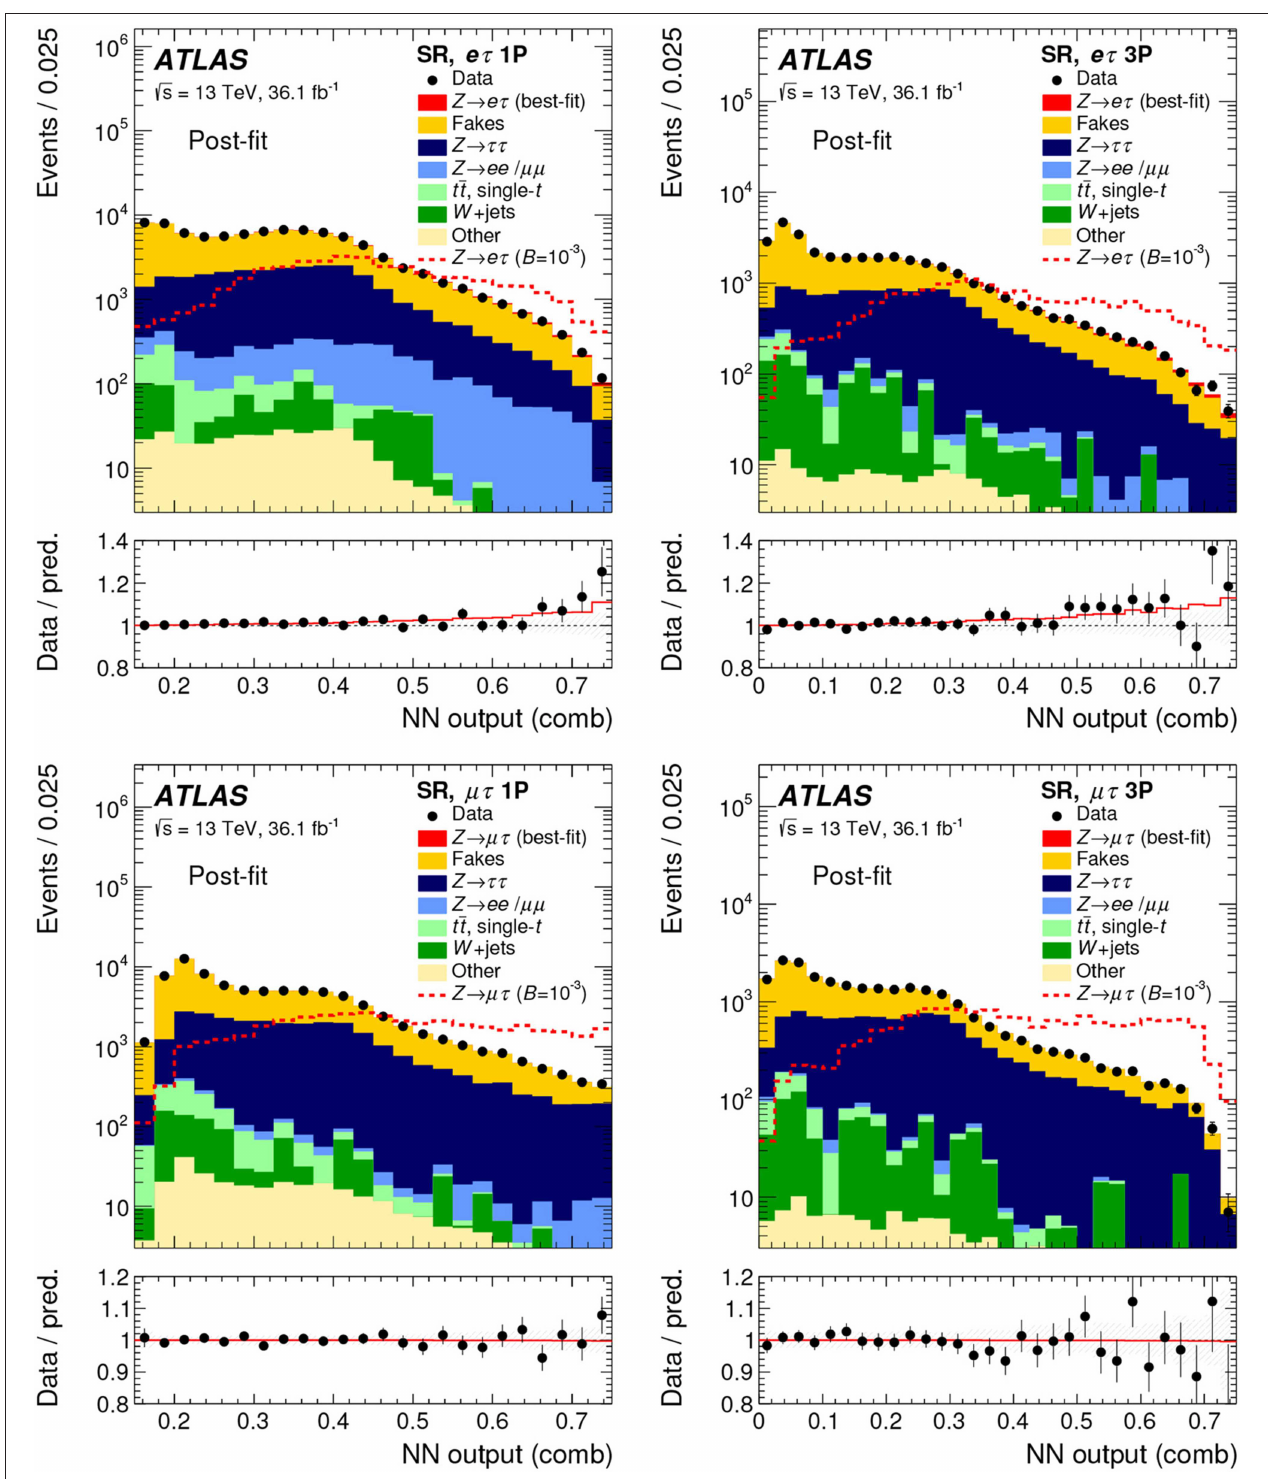
FIGURE 1 | Observed and expected post-fit distributions of the combined NN outputs in the SR are shown for the e τ (top row) and µτ (bottom row) searches, separately for 1-prong (left column) and 3-prong events (right column). The overlaid dashed line represents the expected distribution for the signal normalized to B ( Z ℓτ ) 10 − 3 . The bottom panels in each plot display the ratios of the observed data (dots) and the post-fit background plus signal (solid line) over the post-fit → = background. The hatched areas correspond to the combined statistical and systematic uncertainties. Reproduced from ATLAS Collaboration [38] under the Creative Commons CC-BY-4